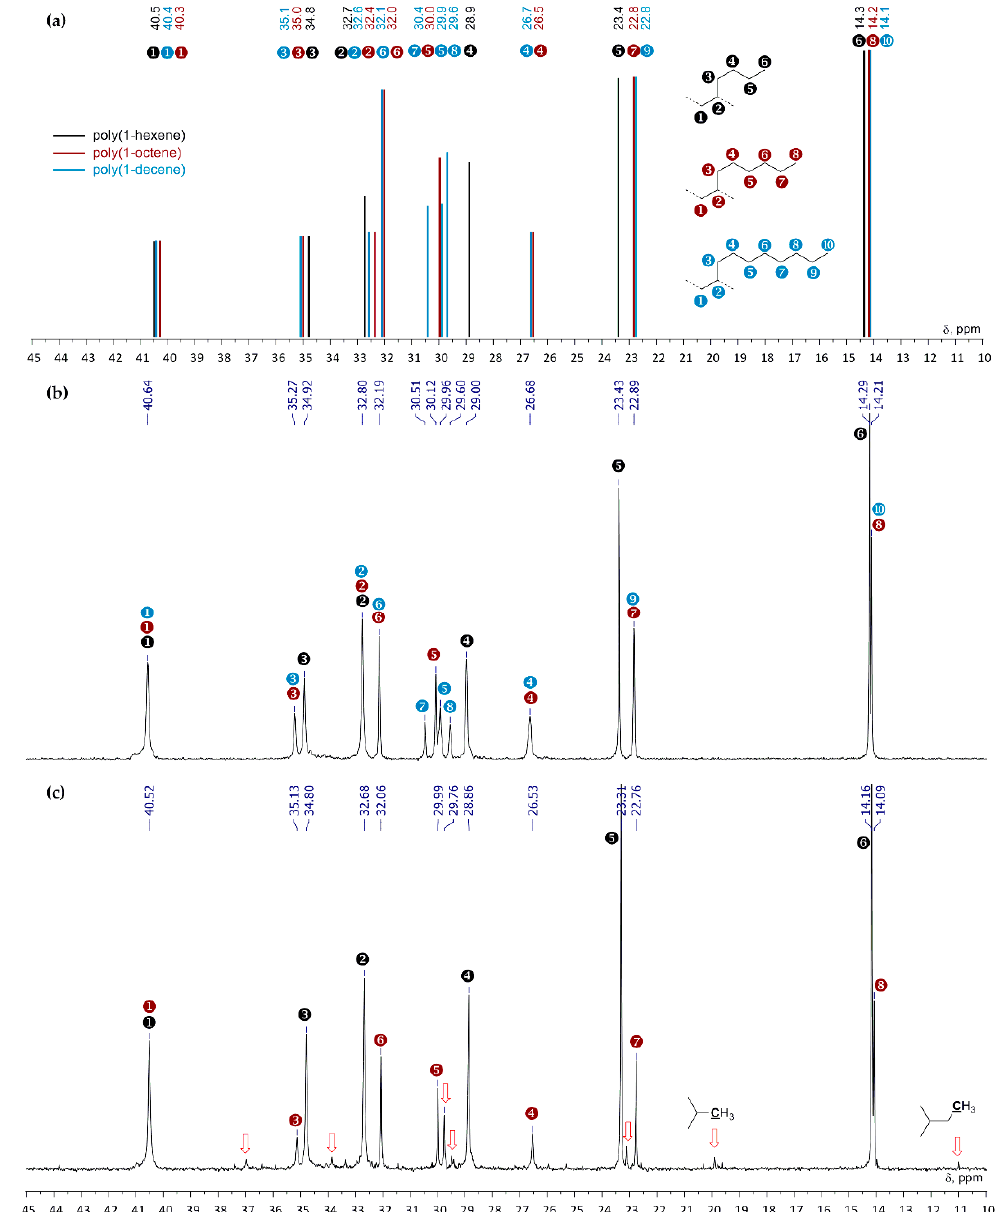
Figure 2. ( a ) Schematic reference 13 C { 1 H} NMR spectra of isotactic poly(1-hexene), poly(1-octene), and poly(1-decene) ( 13 C { 1 H} NMR spectra of these homopolymers are presented in Figure S4 in the Supplementary Materials); 13 C { 1 H} NMR spectra (CDCl 3 , 50 ◦ C, 101 MHz) of the copolymers P2c ( b ) and P2 ( c ). New signals in spectrum of P2 are pointed by red